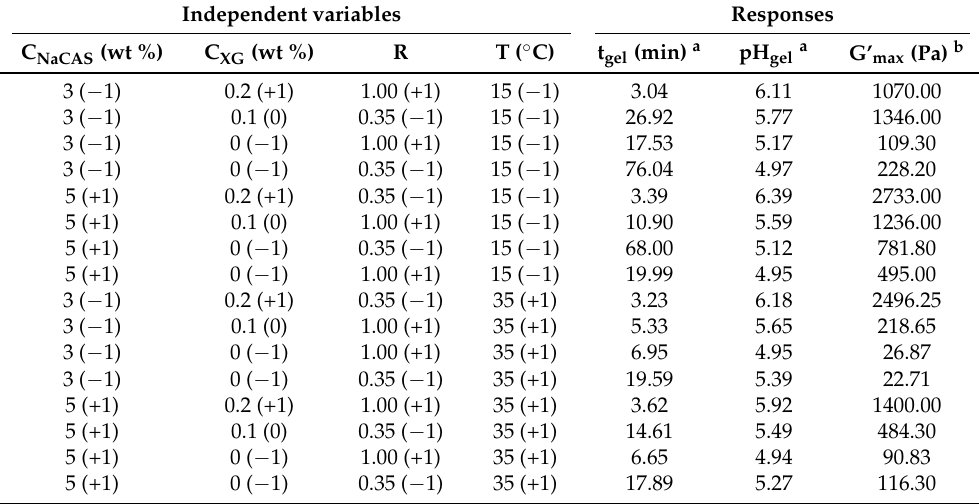
Table 1. Gelation times (t gel ), gelation pH (pH gel ) and maximum elastic modulus (G’ max ) as a function of the coded values for sodium caseinate concentrations (C NaCAS ), xanthan gum concentrations (C XG ), temperature (T) and GDL mass fraction/NaCAS mass fraction ratio (R) used in the experimental design, with the respective real values.